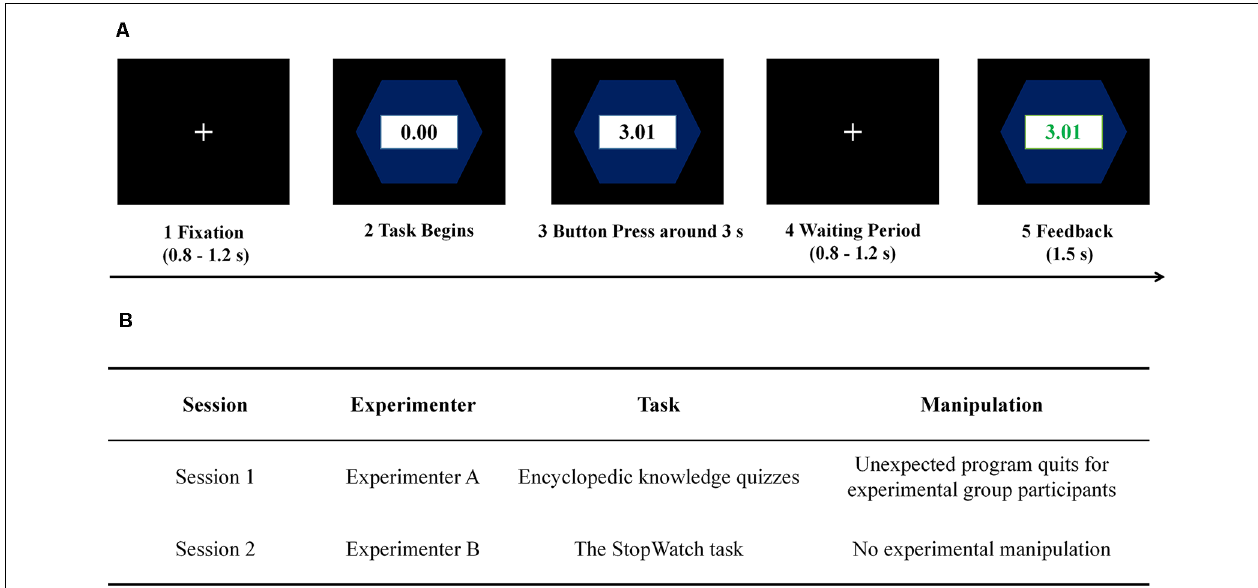
FIGURE 1 | Demonstration of the experimental paradigm. (A) The StopWatch (SW) task. (B) The overall experimental procedure.